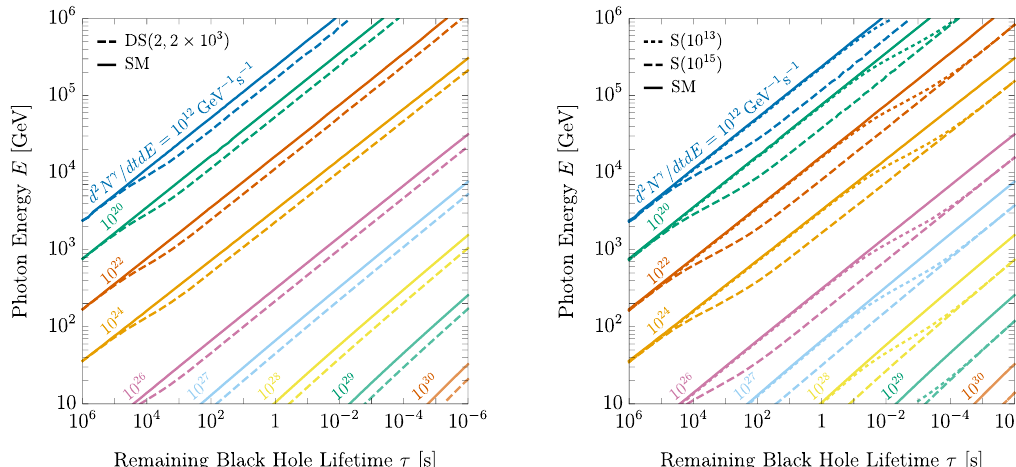
Figure 7 . Contours of the total photon flux as a function of remaining time, τ , and photon energy, E . We show the SM expectation with solid contours and in dashed contours we show the DS (2 , 2 × 10 3 GeV ) benchmark (left), the string inspired benchmarks